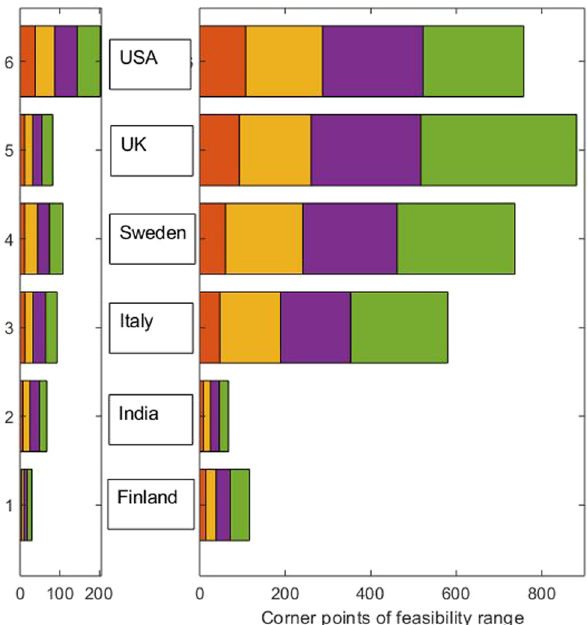
Figure 5: Parameters ( ) x min j , ( ) c l j . c j , ( ) c h j and ( ) x max j for the daily new con fi rmed cases: fi rst 240 days ( left ) and all data ( right ) .